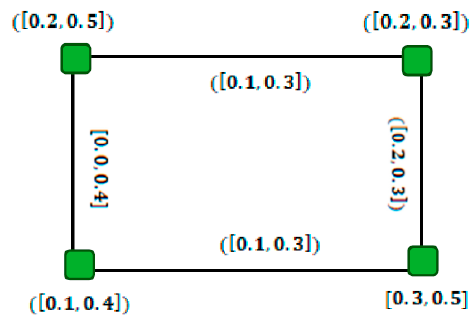
Figure 13. The complement of graph depicted in Figure 12.